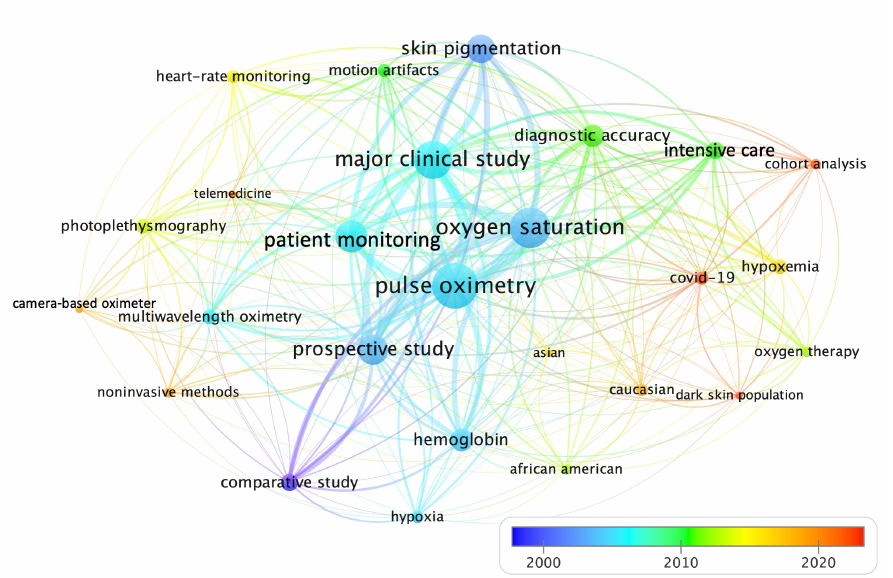
Figure 4. Network map of average co-occurrence citation of the most relevant keywords and dynamic view over